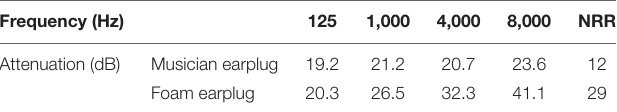
TABLE 1 | Frequency-specific attenuation and Noise Reduction Rating of the foam and musician earplugs as advertised by the manufacturers. Frequency (Hz) 125 1,000 4,000 8,000 NRR Attenuation (dB) Musician earplug 19.2 Foam